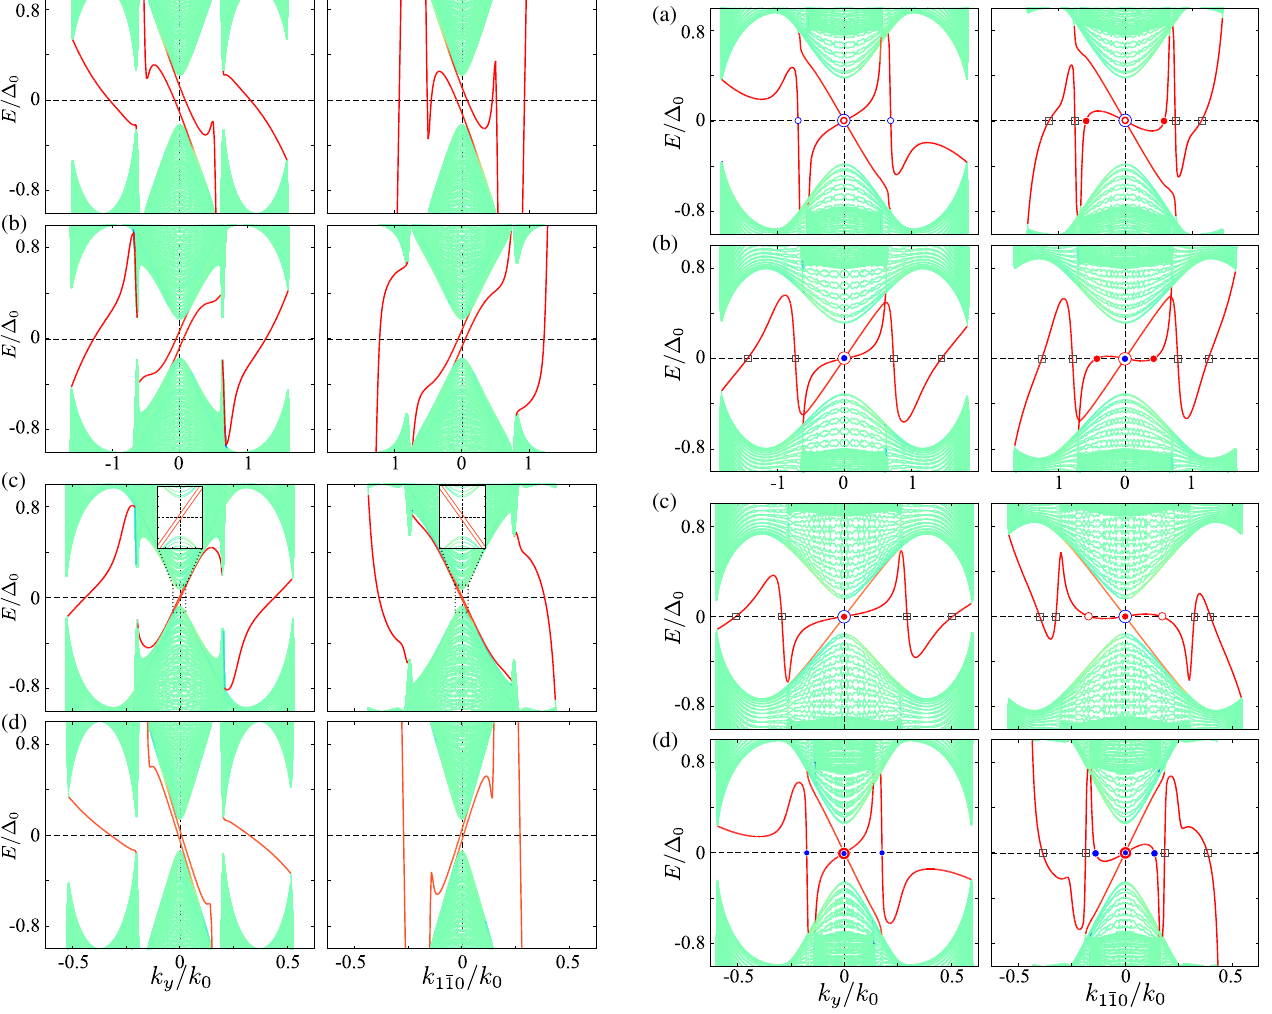
FIG. 8. Energy spectrum of the slab in different topological FIG. 9. Energy spectrum of the slab in different topological (left) and k 1¯10 ¼ phases of a small j μ j regime along the k ffiffiffi x phases for a large j μ j regime, μ ¼ − 1 . 25 m 0 . The red and blue p 2 (right) directions. For better illustration, we display ð k x − k y Þ = symbols denote the zero-energy state of helical Majorana the surface states localized only at z ¼ − L= 2 highlighted by the fermions originating from the outer and inner Fermi surfaces, red curves. The momentum unit is k 0 ¼ m 0 =v 1 . Insets in (b) are respectively. The closed and open ones indicate the positive and magnified images of the center of the Brillouin zone and close to negative helicities, respectively. The open square symbols in- E ¼ 0 . Here, Δ 0 ¼ 0 . 025 m 0 , μ ¼ − 0 . 75 m 0 , v 2 =v 1 ¼ − 0 . 5 (a), dicate pairs of helical Majorana fermions with opposite helicities, − 0 . 2 (b), 2.5 (c), and 4 (d), and α ¼ 0 . 64 v 2 which can annihilate via continuous deformation. The other 1 =m 0 (a),(b) and 6 . 25 v 2 conditions are the same as in Fig. 1 =m 0 (c),(d).